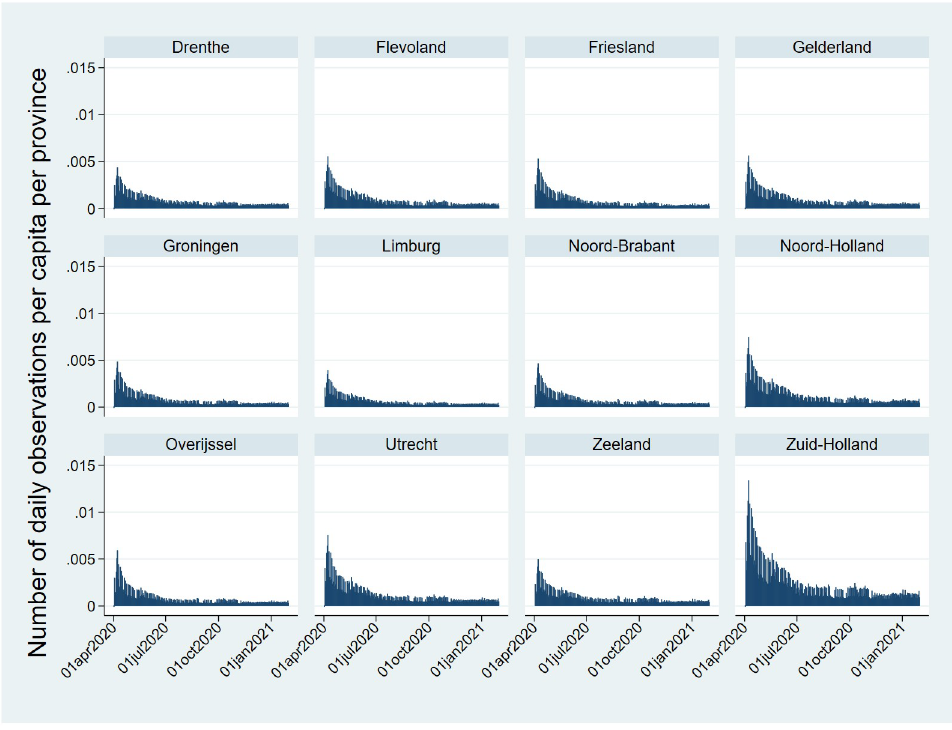
Fig 3. Number of observations per capita per province in the Netherlands.